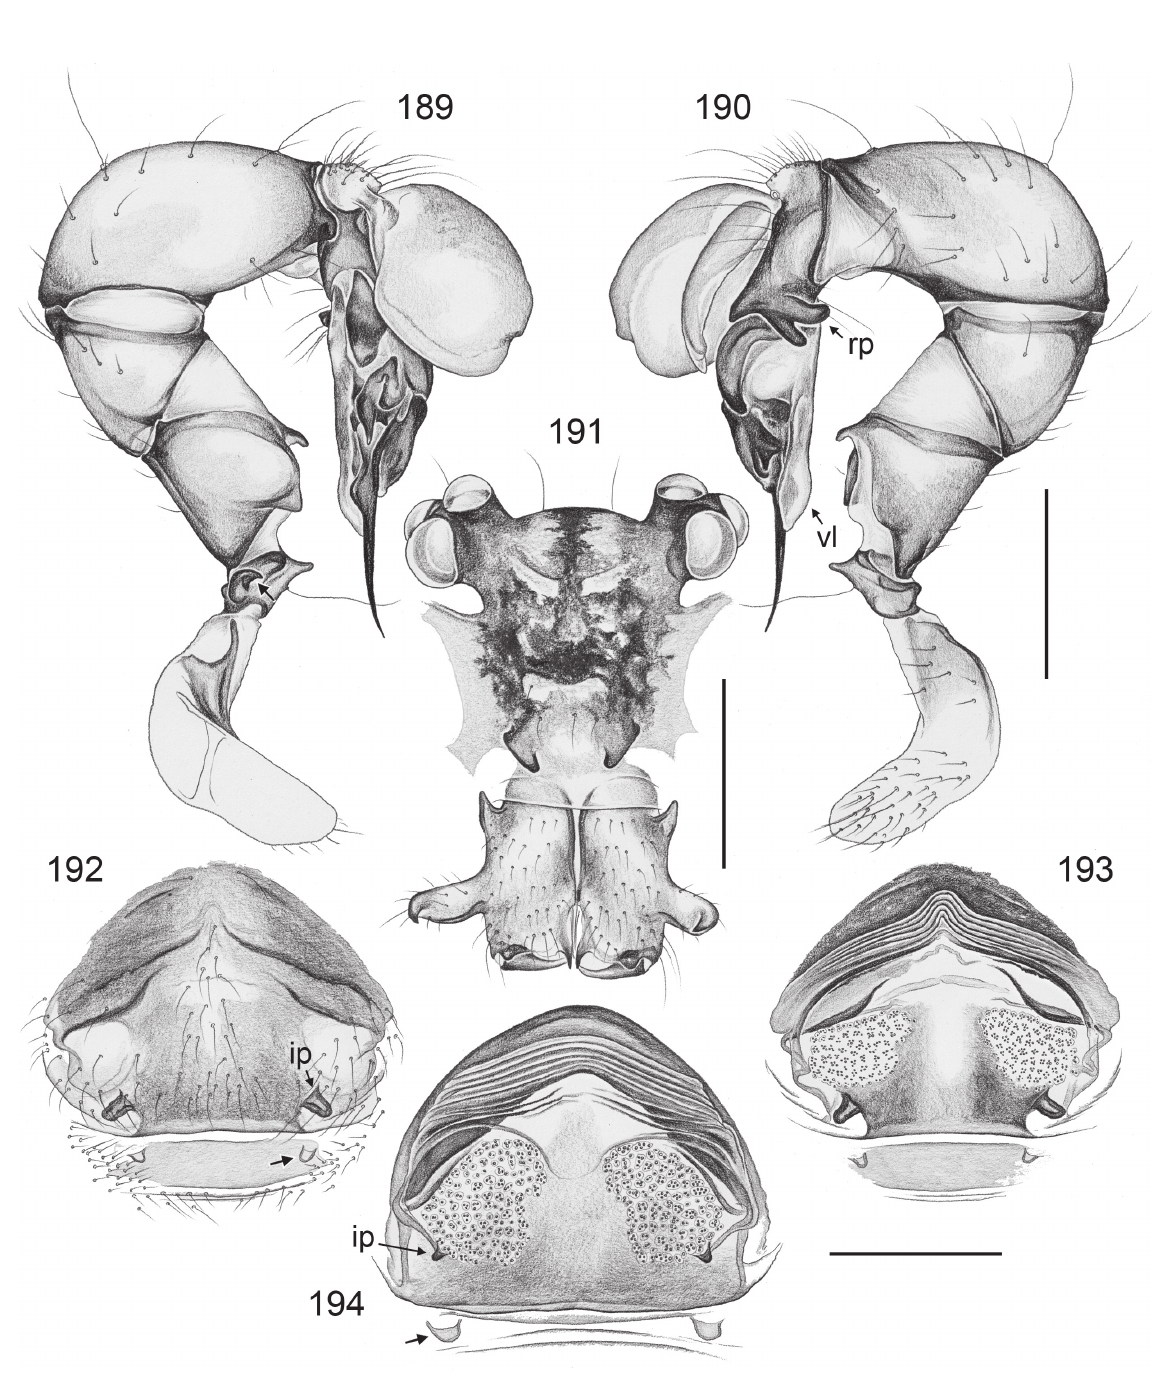
Figs 189–194. — 189–193. Aetana abadae Huber, sp. nov. 189–190. Left male palp, prolateral and retrolateral views. 191. Male prosoma, oblique frontal view. 192–193. Cleared female genitalia, ventral and dorsal views. — 194 . A. omayan Huber, 2005, cleared female genitalia, dorsal view. Arrows point at membranous pockets. ip = internal sclerotized pocket; rp = retrolatero-ventral process; vl = ventral lamina. Scale lines: 0.5 mm (female genitalia at same